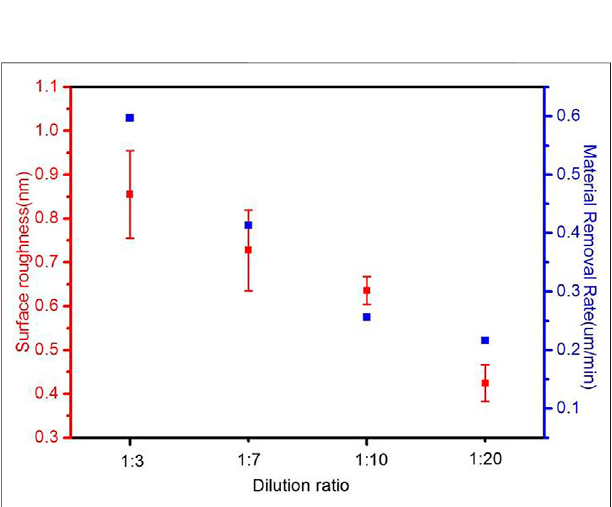
FIGURE 3 | RMS roughness and MRR of GaSb wafers as a function of the dilution ratio of the polishing